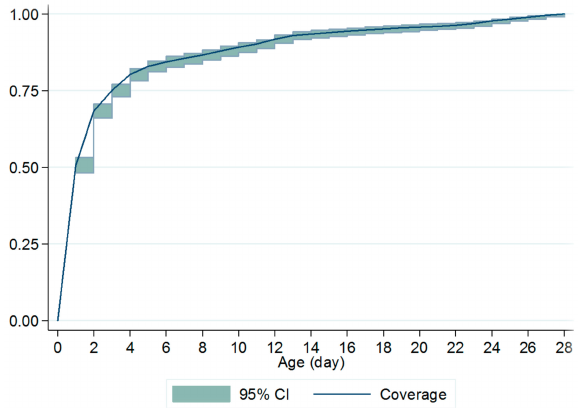
Figure 1. Inverse Kaplan–Meier curves showing the proportion of children immunized with BCG among the surveyed children with immunization cards (N = 1393).